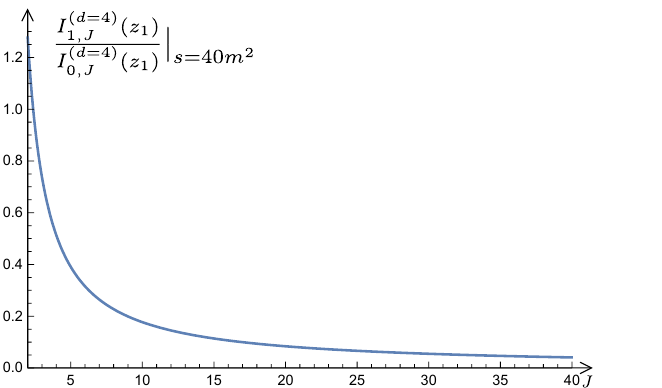
Figure 13 . We plot the ratio of the leading and subleading threshold integrals in (7.10) as a function of spin J for s = 40 m 2